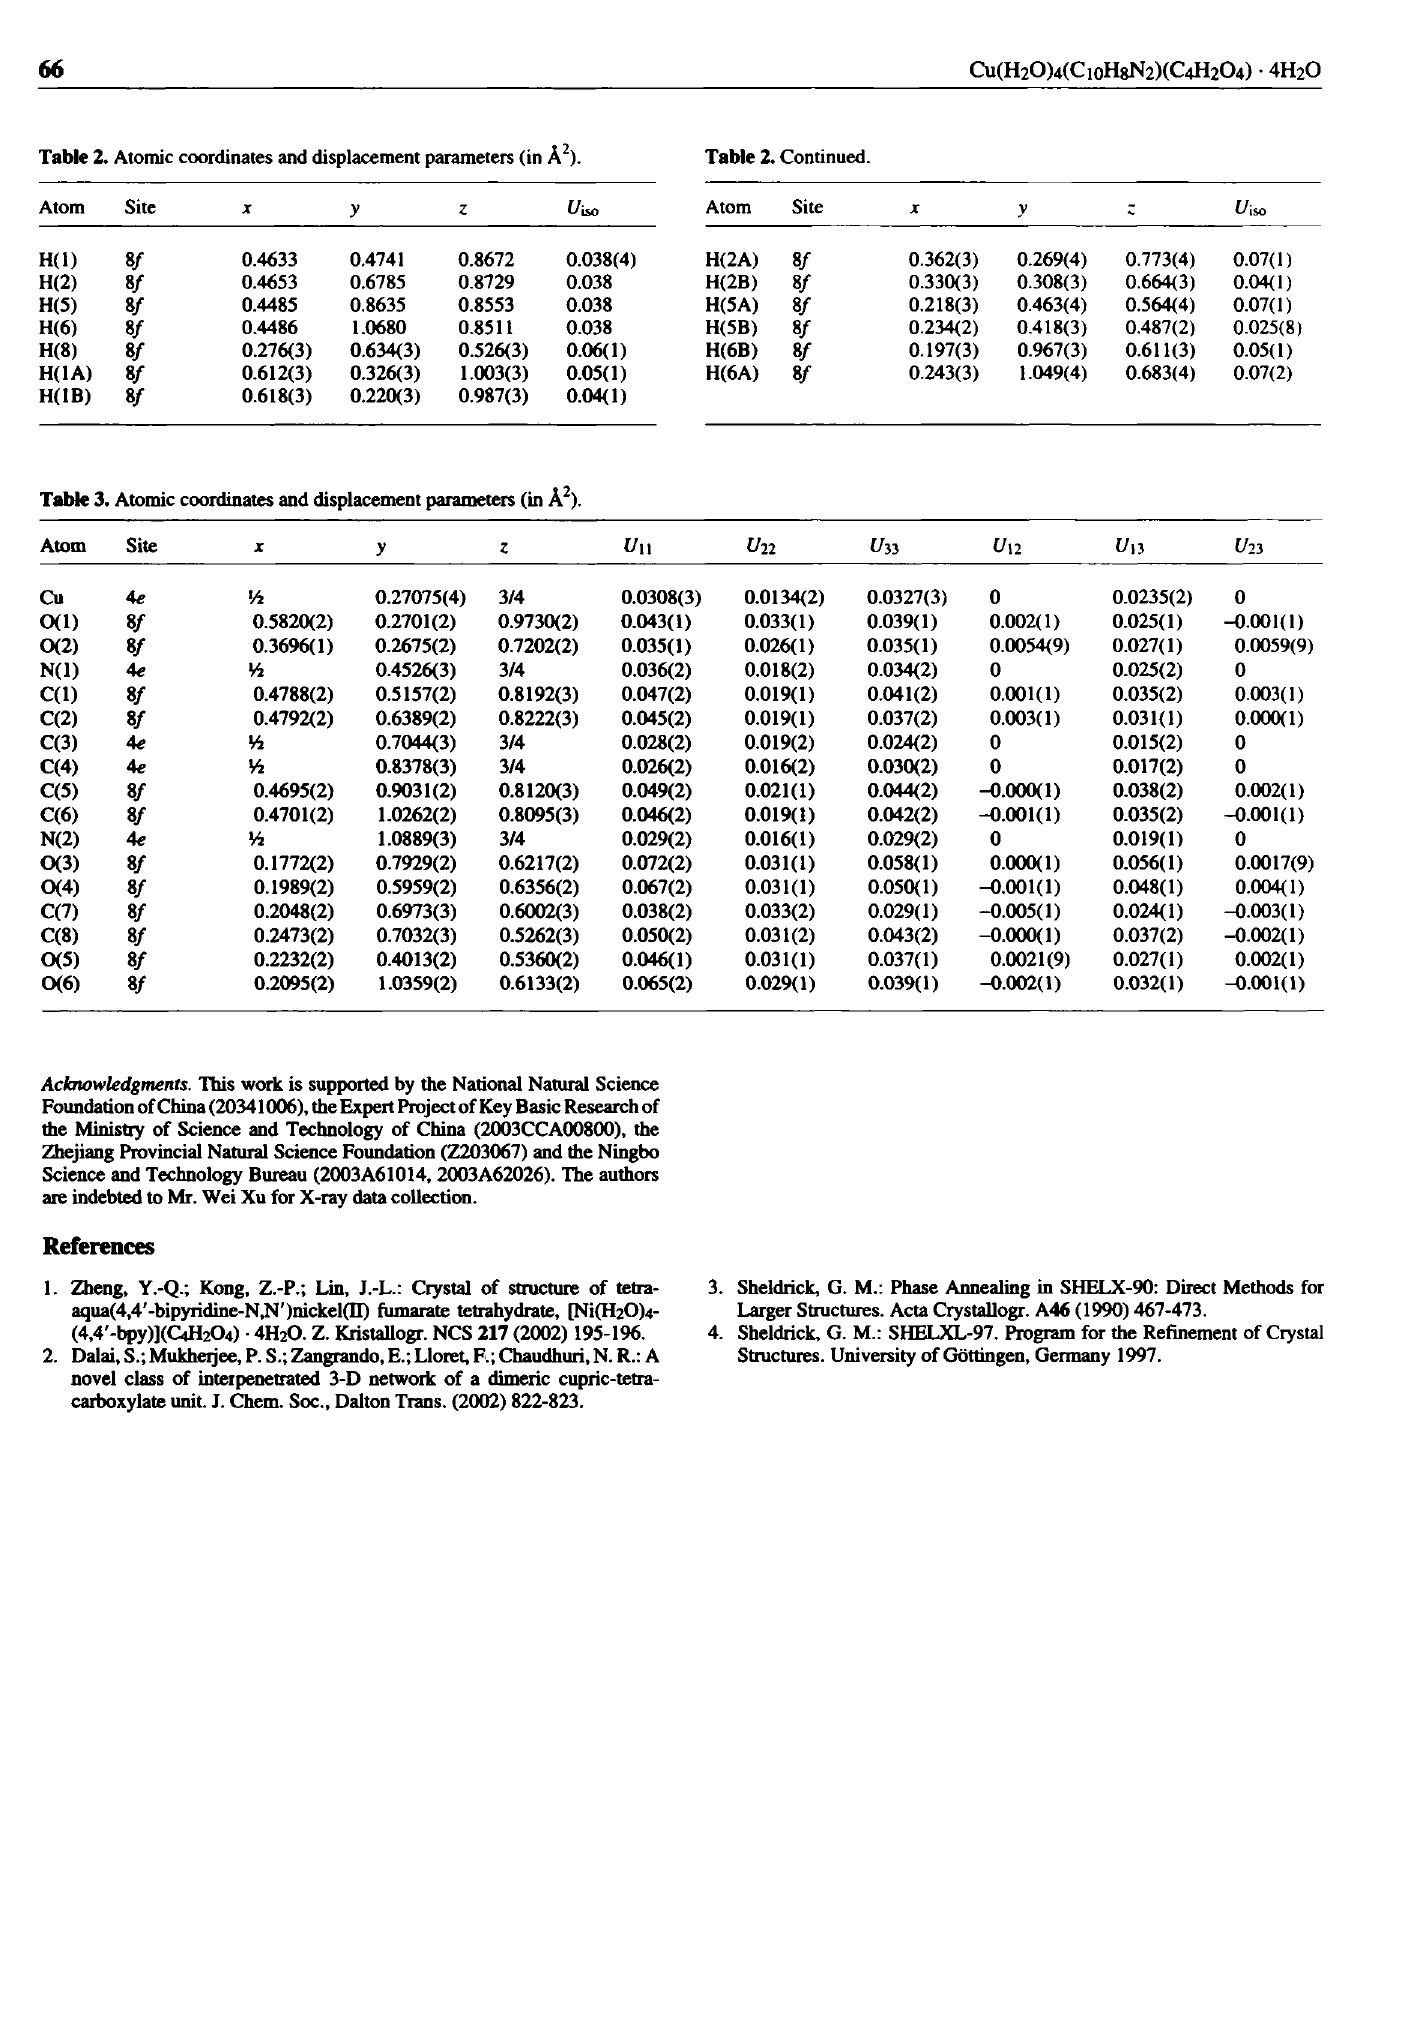
Table 3. Atomic coordinates and displacement parameters (in Â 2